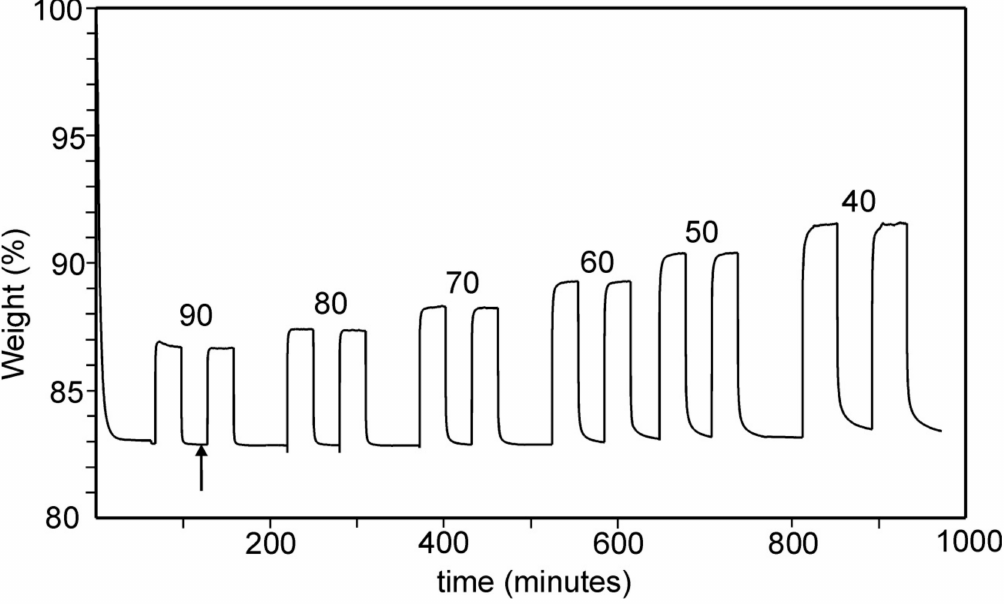
Figure 6. TG curves for adsorption / desorption of CO 2 on Rb 2 / 3 Cu[Fe(CN) 6 ] 2 / 3 at indicated temperatures between 40 and 90 ◦ C. The arrow indicates the point taken for calculation of the number n of water molecules per unit cell.